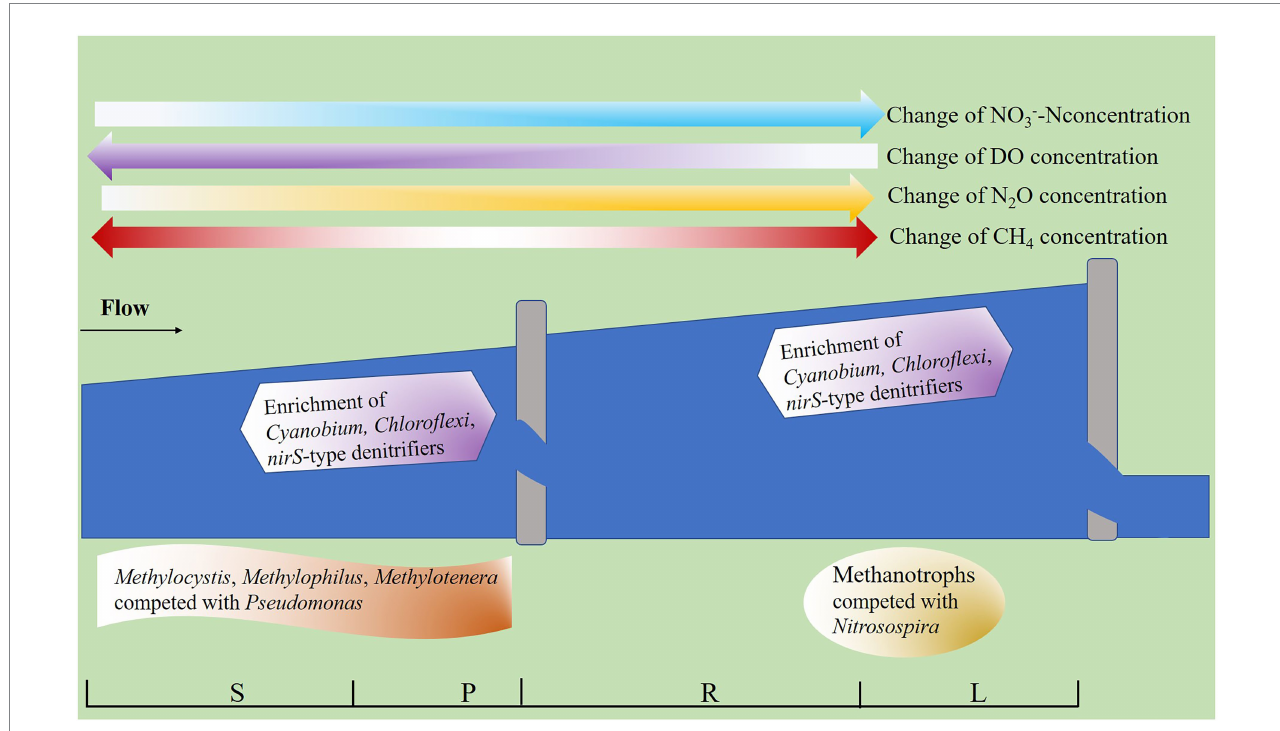
FIGURE 9 Accumulation patterns of N 2 O and CH 4 in fragmented rivers. The water concentration of N 2 O increases with the height of barriers. The barriers (less than 2 m) inhibit CH 4 accumulation, while barriers (higher than 2 m, less than 5 m high) promote CH 4 accumulation. The darker the arrow, the higher the solute